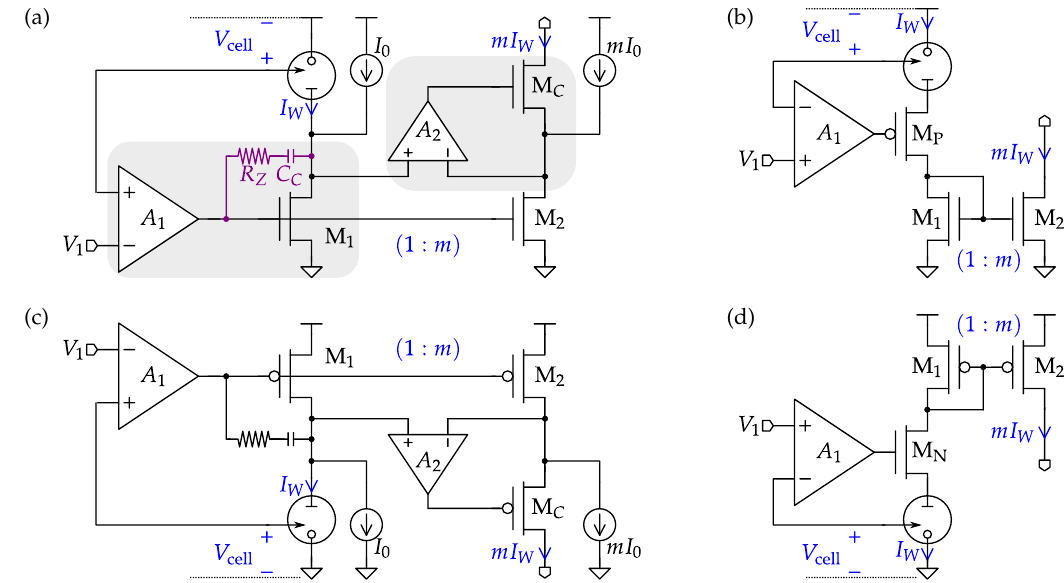
Figure 12. Potentiostats based on current mirror amplifiers. ( a ) n-type mirror embedded in the amplifier; ( b ) n-type mirror with current buffer; ( c ) p-type mirror embedded in the amplifier; ( d ) p-type mirror with current